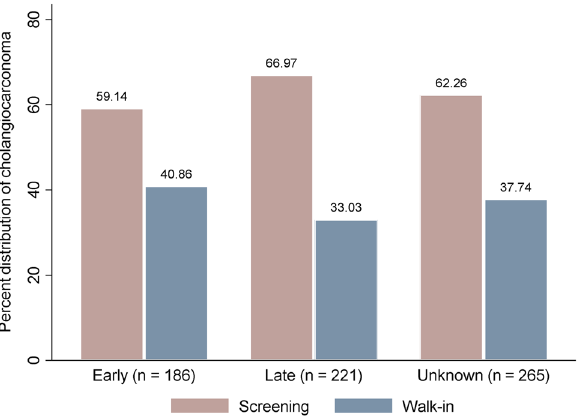
Figure 2. Percent distribution of cholangiocarcinoma according to cohort types. n—Number of cholangiocarcinoma patients.